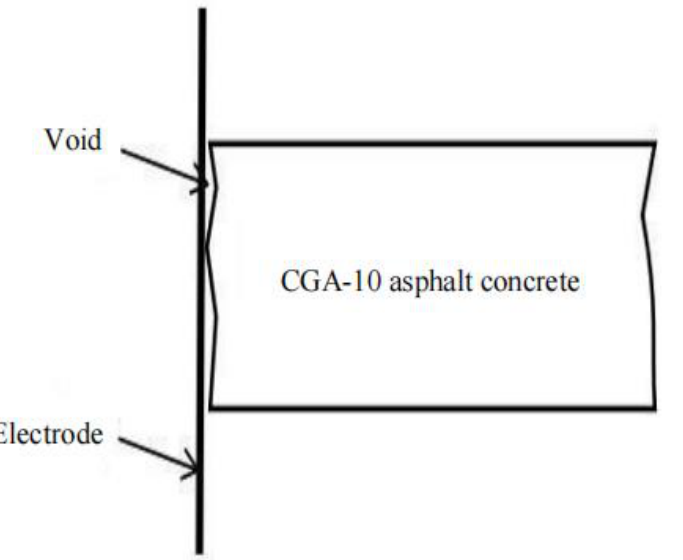
Figure 15. Contact surface between CGA-10 specimen and electrode sheet.